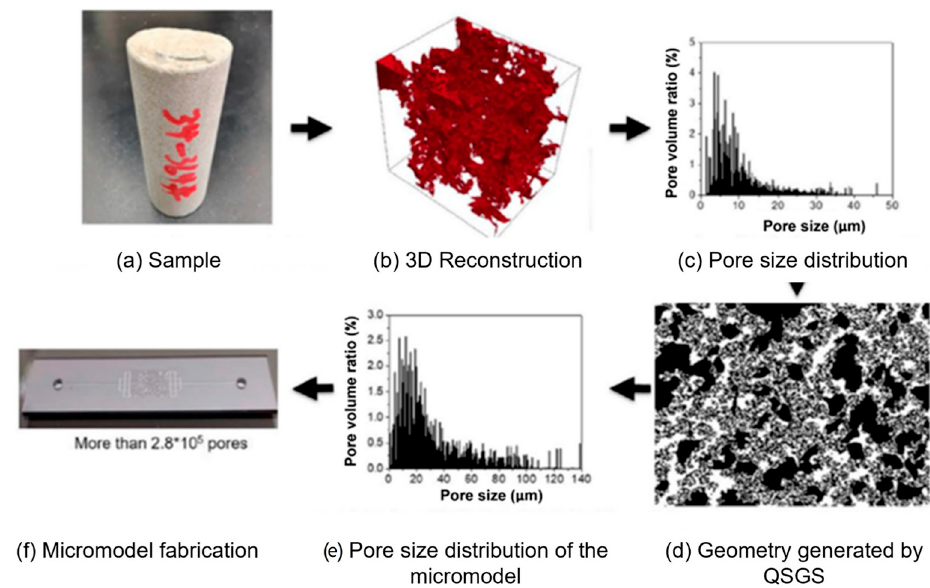
Figure 5. Example of a micromodel design using a multi-step approach [25].